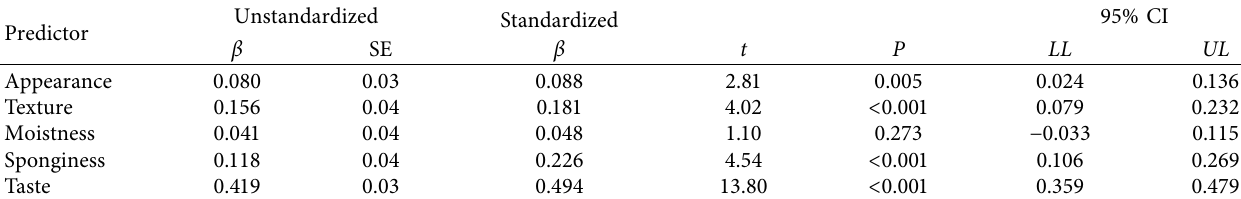
Table 5: Multiple linear regression model 1 using sensory attributes to predict overall liking of muffins. Predictor